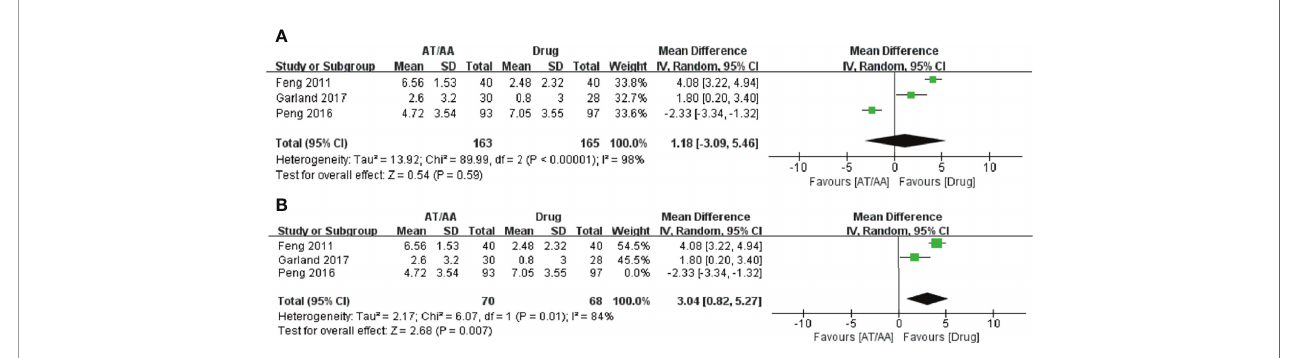
FIGURE 4 | Forest plots of the (A) short-term effect and (B) long-term effect of acupuncture or auricular acupressure for